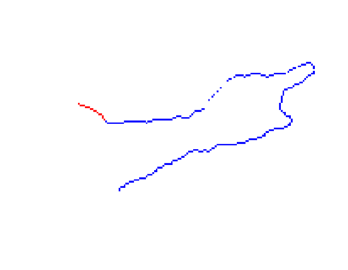
Figure 5. Pixels on the perimeter of an arm segment and adjacent to the rest of the foreground (binary image B inner , also shown in Figure 4). The pixels used to connect graph layers (binary image B connect ) are shown in